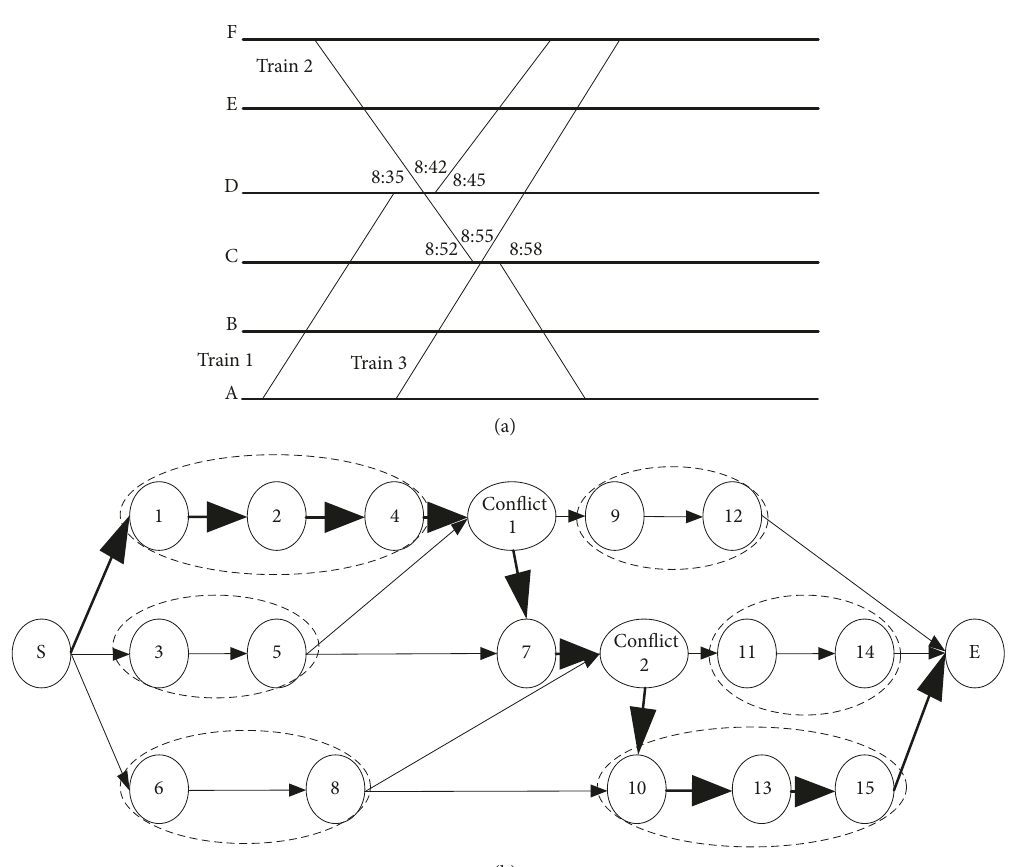
Figure 5: (a) Illustration of the example timetable, (b) directed acyclic graph, and critical path for the presented example.